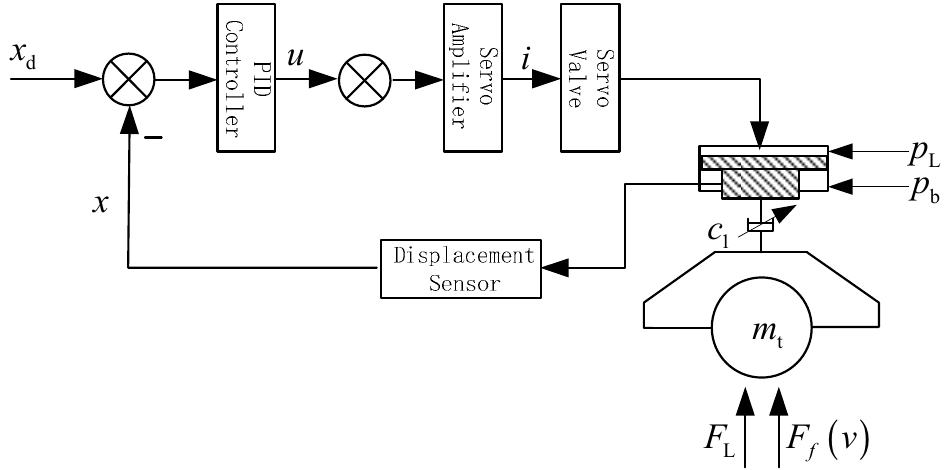
Figure 2. Structural diagram of the vertical vibration of hydraulic screw down system.